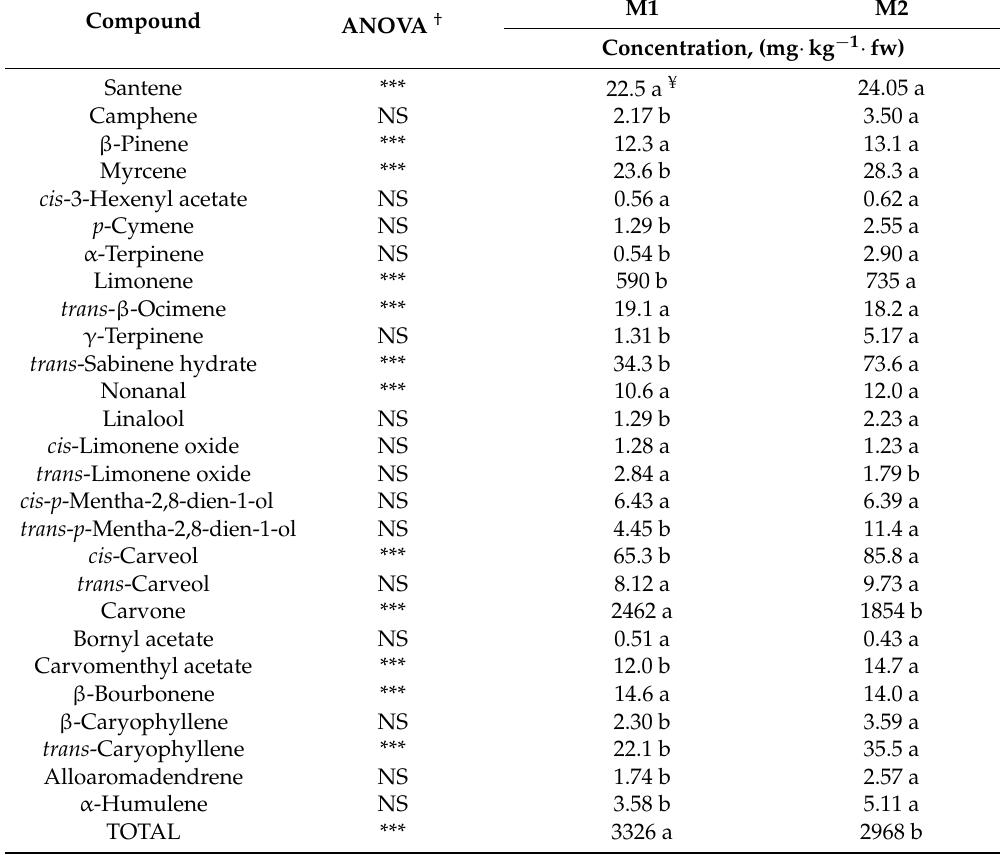
Table 5. Volatile composition of mint essential oil at two commercial stages (mg ¨ kg ´ 1 ¨ fw). Compound ANOVA